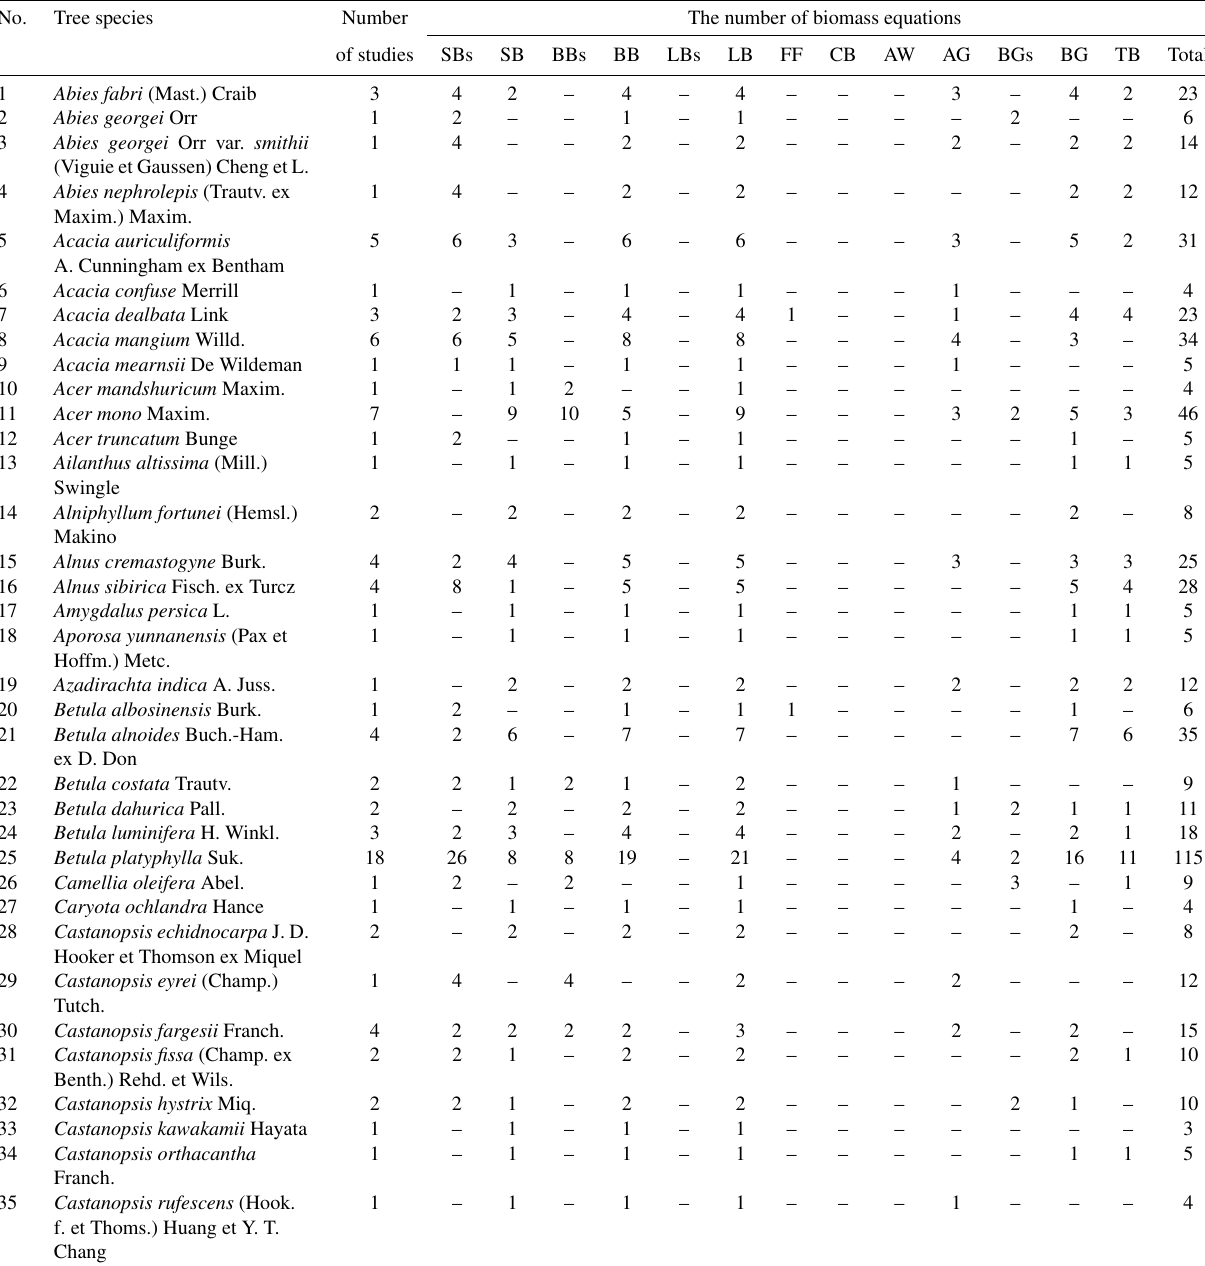
Table D1. Number of compiled biomass equations by tree species and biomass component. “–” denotes no equations for a tree biomass component (group). Species names are checked with online Flora of China (http://frps.iplant.cn/, last access: 1 November 2019). Mixed forest in the “tree species” column refer to tree species pooled (e.g., deciduous broadleaved trees, a certain diameter-class mixed species, even generalized) that equations are developed for. Abbreviations: SBs, stem biomass subcomponents (stem wood and bark); SB, stem biomass; BBs, branch biomass subcomponents (e.g., different aged branches); BB, branch biomass; LBs, leaf biomass subcomponents (different aged leaves); LB, leaf biomass; FF, flower and fruit biomass; CB, tree crown biomass (BB + LB); AW, aboveground